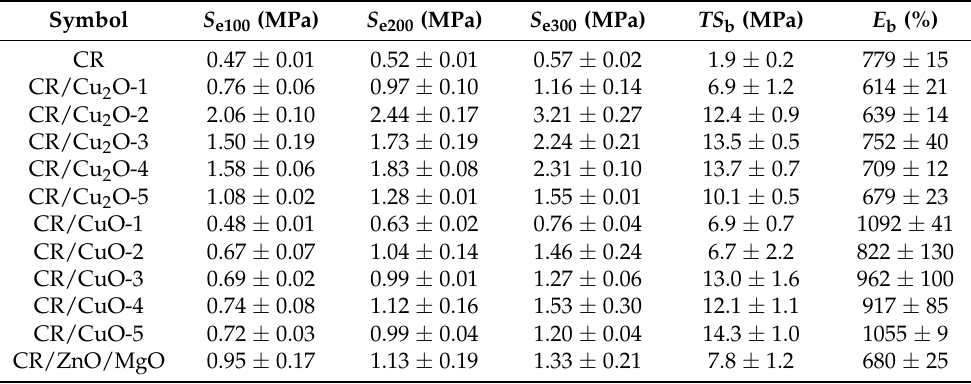
Table 4. Mechanical properties of CR vulcanizates; T = 160 ◦ C, t = 45